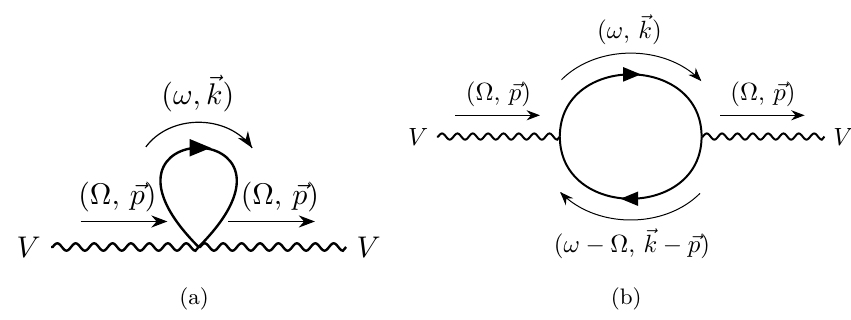
Figure 2 . One-loop contributions to the self-energy of the vector